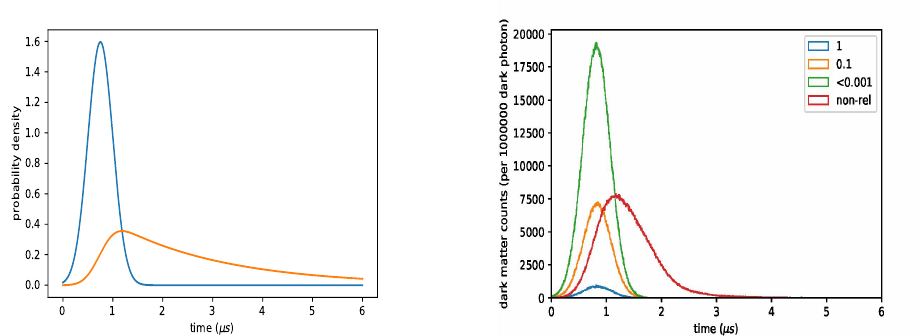
Figure 13.3: Timing distribution for the prompt and delayed components arising from the neutrinos(left) and DM arising from the dark photon (relativistic with ≤ 138 MeV and non relativistic cases) for various dark photon lifetime m darkphoton scenarios (1, 2, ≤ 10 − 3 µ